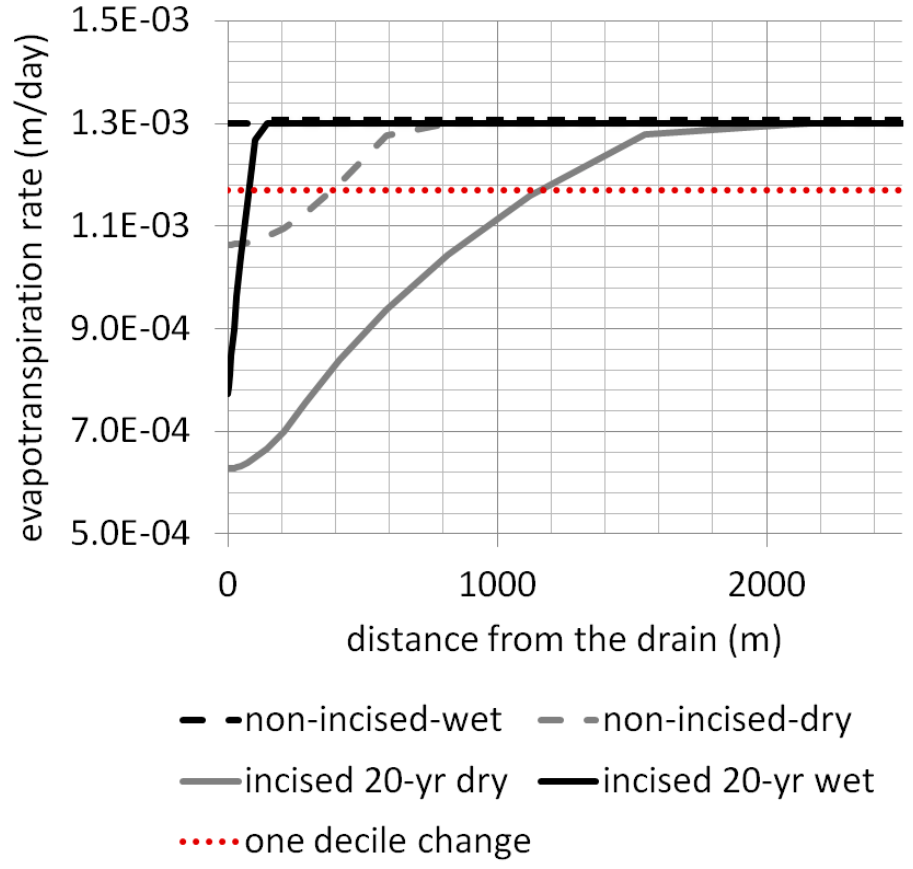
Figure 11. Model results for the spatial variation of evapotranspiration in the initial (dashed line) and incised model after 20 years (solid line) (K = 7 m/day, specific yield = 0.12).